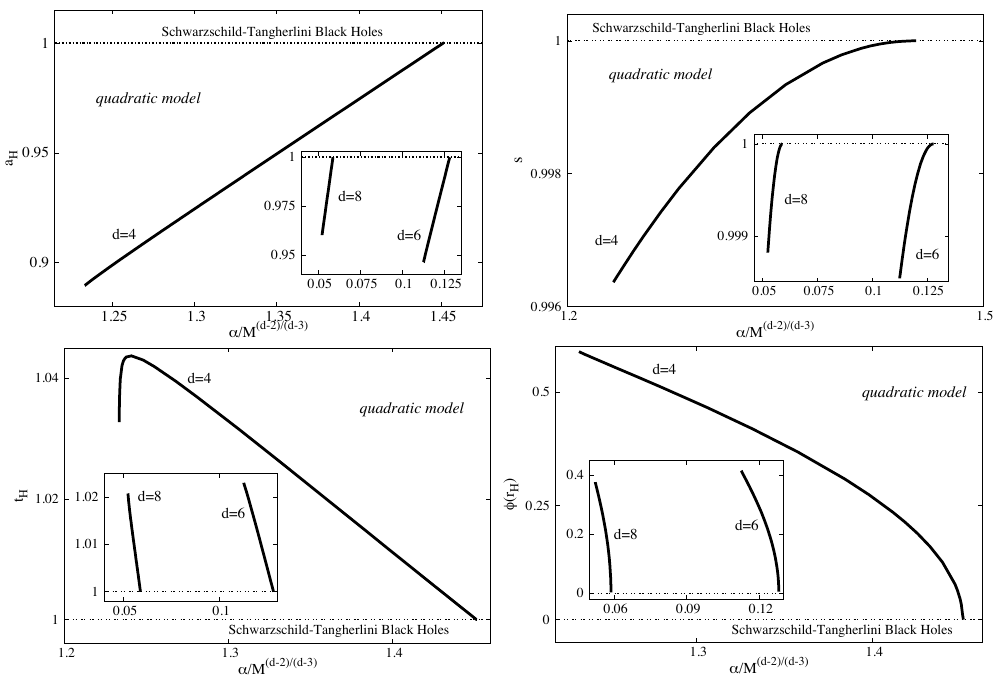
Figure 3 . Reduced area (top left panel), reduced entropy (top right panel), reduced temperature (bottom left panel) and the scalar (cid:12)eld at the horizon (bottom right panel) vs. the coupling (normal- ized by the mass) for scalarized BHs in the extended scalar-tensor model in d = 4 ; 6 ; 8